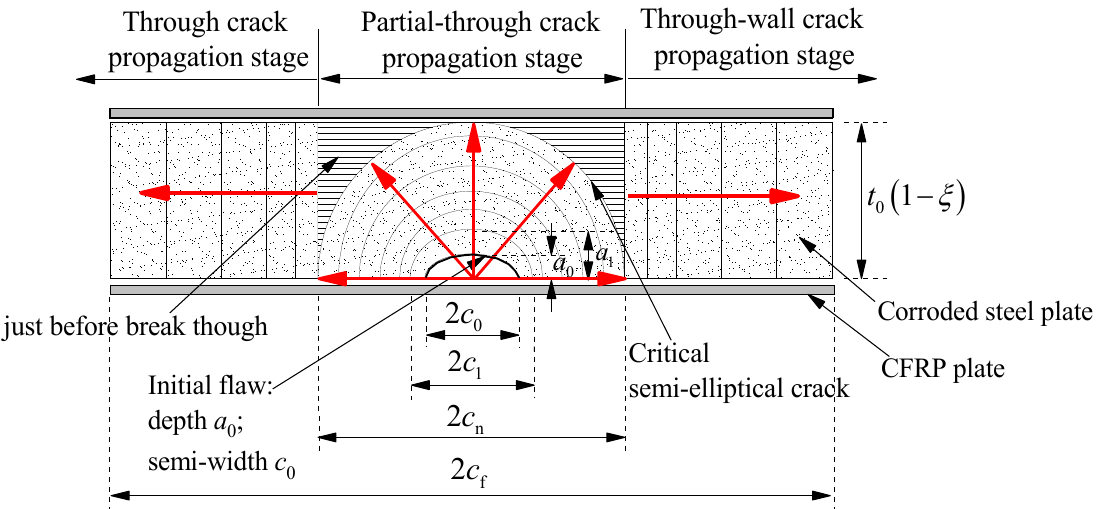
direction of the steel plate is ignored, and the crack propagation rate is calculated by taking the SIF of the crack tip in the middle of the thickness of the steel plate.